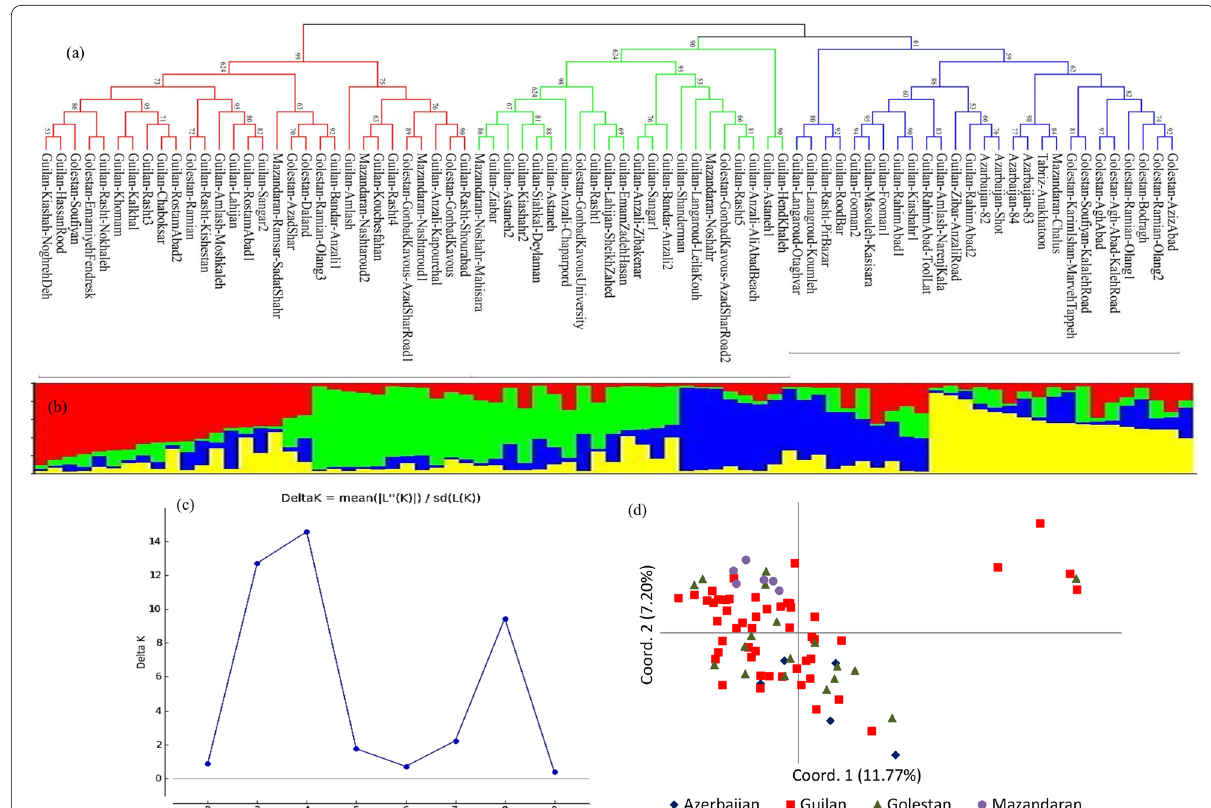
Fig. 3 The genetic relationships and population structure of the 79 Ae. tauschii accessions based on REMAP data concluded from a distance and model-based cluster analyses and PCoA. a Neighbor-joining phylogenetic tree, b population structure on K versus Δ K for determining ideal K -value, and d PCoA plot based on the first two